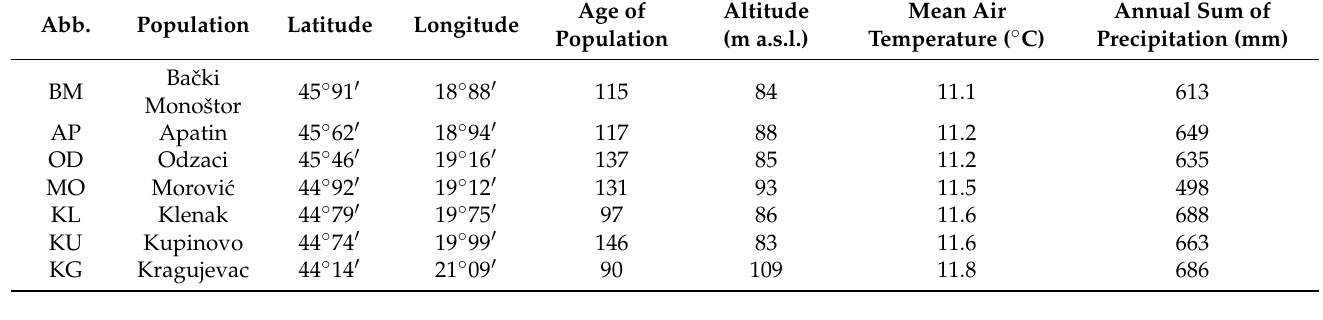
Table 1. Population names, geographic coordinates, altitude, mean air temperature, and annual sum of precipitations. Abb.